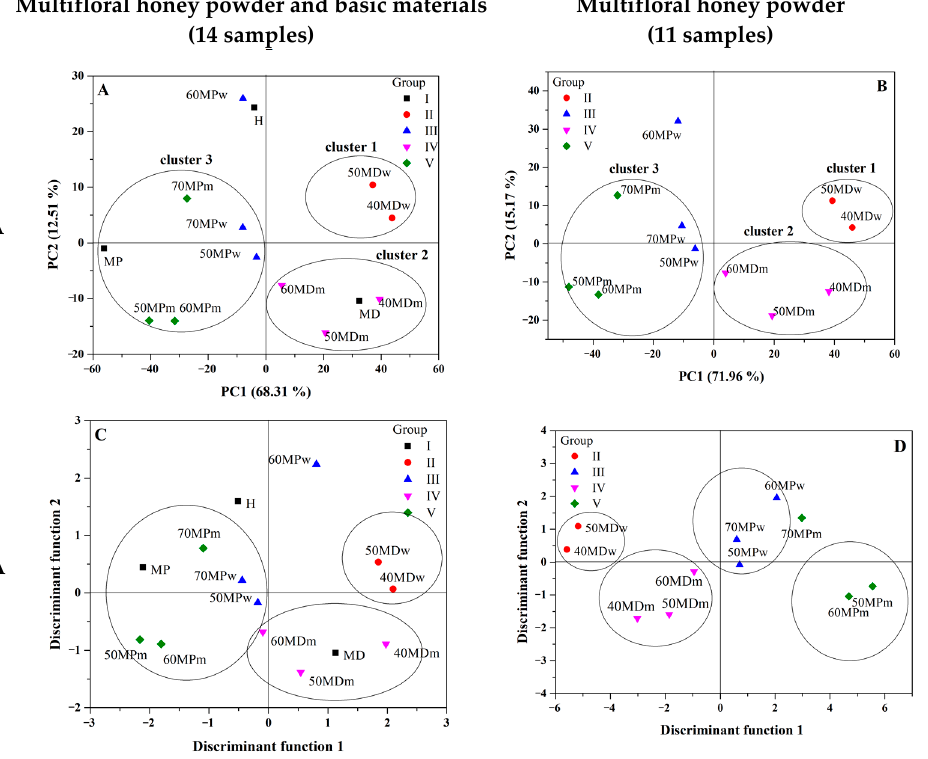
Figure 3. Principal component analysis (PCA) two-dimensional (2D) score plot (PC1 versus PC2) calculated for the data acquired from the FTIR spectra in the range between 1800—750 cm − 1 . ( A )—analysis conducted for 14 samples (I-V group) and ( B )—analysis conducted for 11 samples (II-V group). Linear Discriminant Analysis (LDA) score plot of multifloral honeys of different carrier and diluent by using first three PCs as variables. ( C )—analysis conducted for 14 samples (I-V group) and ( D )—analysis conducted for 11 samples (II-V group). Range between 1800–750 cm − 1 .